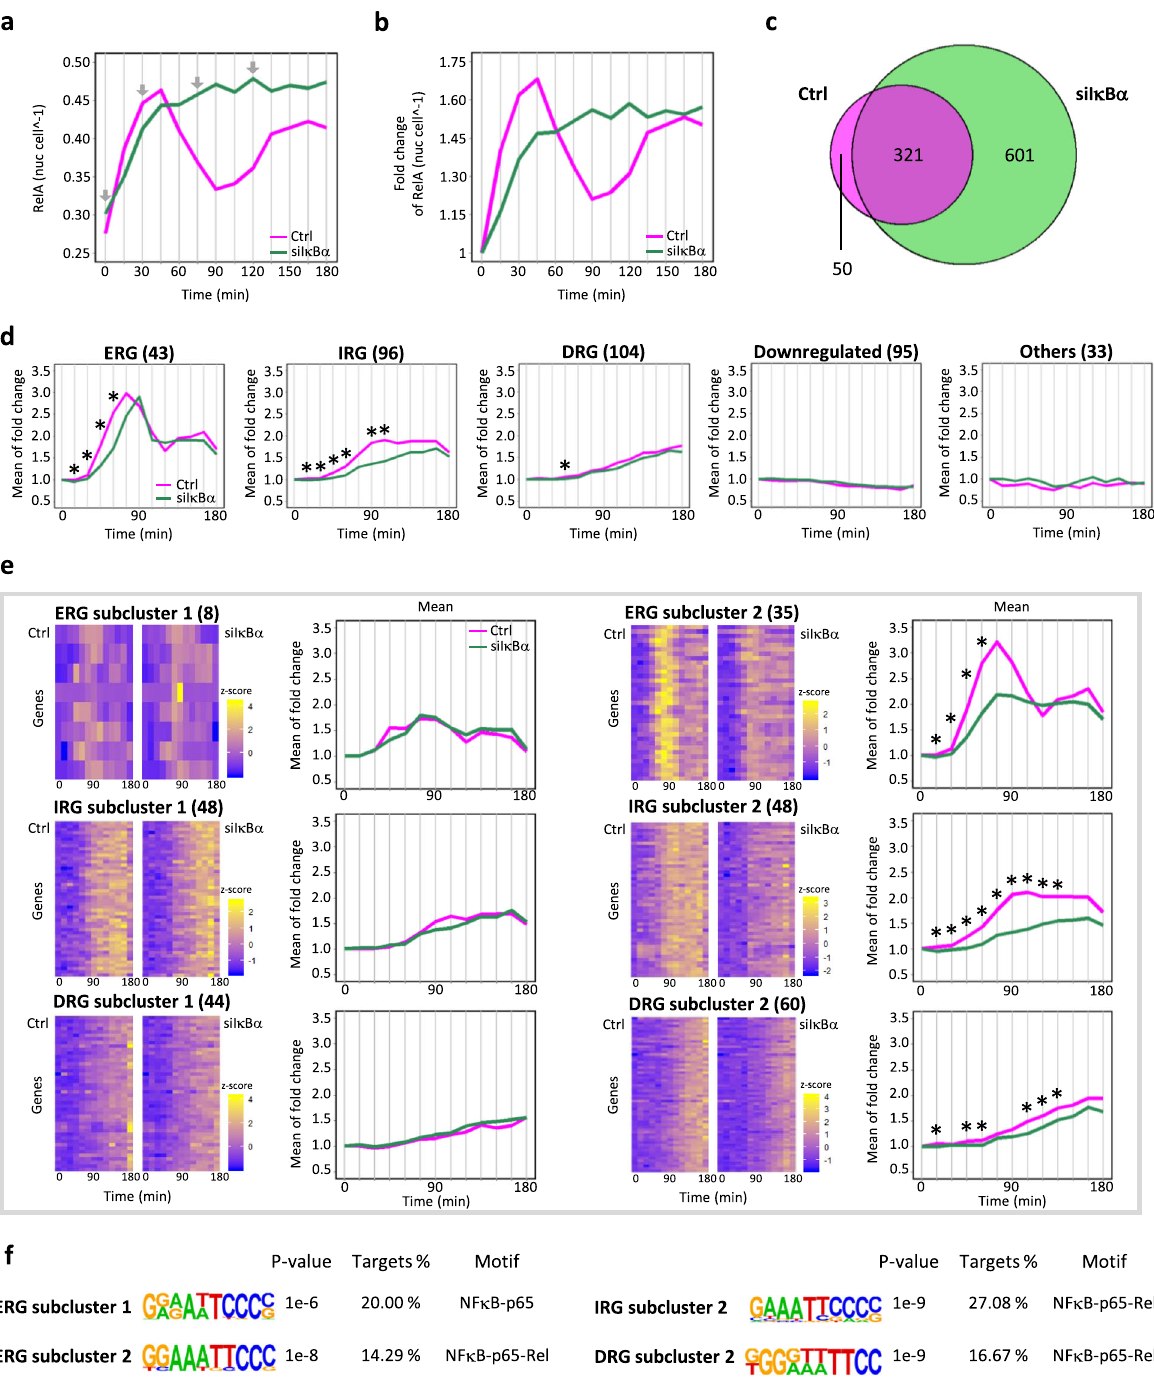
Fig. 1 TNF (tumor necrosis factor)-induced RelA nuclear translocation and expression of NF κ B target gene clusters. Time-course nuclear NF κ B abundance ( a ) and fold change ( b ) from fi xed-cell immuno fl uorescence of MCF-7 cells treated with 1 ng mL − 1 TNF in Ctrl (Control) and siI κ B α (I κ B α knockdown). Line graphs represent the means of two biological replicates. Number of cells used to calculate the mean for each time point ranged from 1336 to 2374 cells (Supplementary Table 1). Gray lines indicate the time points where RNA-seq data was measured, and arrows indicate the time points where single-cell ATAC-seq data was measured. Statistical signi fi cance was observed for interpolated (same method used in mathematical modeling) time-course nuclear NF κ B abundance ( p value: 1.039e − 4) and fold change ( p value < 2.2e − 16) between Ctrl and siI κ B α from before stimulation and 75 min (the fi rst peak time point of early response genes) after stimulation by one-tailed Wilcoxon rank-sum test. c Venn diagram of the TNF-induced DEGs in Ctrl and siI κ B α . d Mean of fold change in the expression of fi ve TNF- induced clusters (ERG, IRG, DRG, downregulated, and others) of DEGs in Ctrl. For these 5 clusters, statistical tests were performed for fold change in expression between Ctrl and siI κ B α (* p value < 0.01 by one-tailed Wilcoxon rank sum test). e Two subclusters for each TNF-induced cluster (ERG, IRG, and DRG) in Ctrl (outlier PCSK5 excluded in line graph). For these 6 subclusters, statistical tests were performed for fold change in expression between Ctrl and siI κ B α (* p value < 0.01 by one-tailed Wilcoxon rank-sum test). f κ B motifs that were enriched at promoter regions (±50 bps TSS) of ERG subclusters 1 and 2, IRG subcluster 2, and DRG subcluster